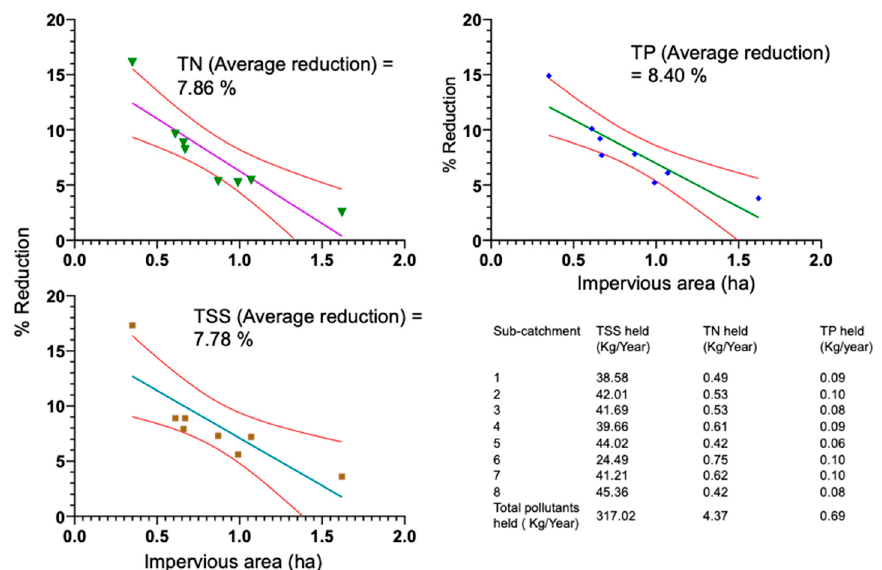
Figure 10. Performance of leaky wells to intercept pollutants from transporting downstream to receiving waters. The trend with increasing impervious are shown along with 95% confidence limits. The average reduction annually is also noted in the figure. The quantity of each pollutant held annually in the catchment, as per the MUSIC predictions are also shown.